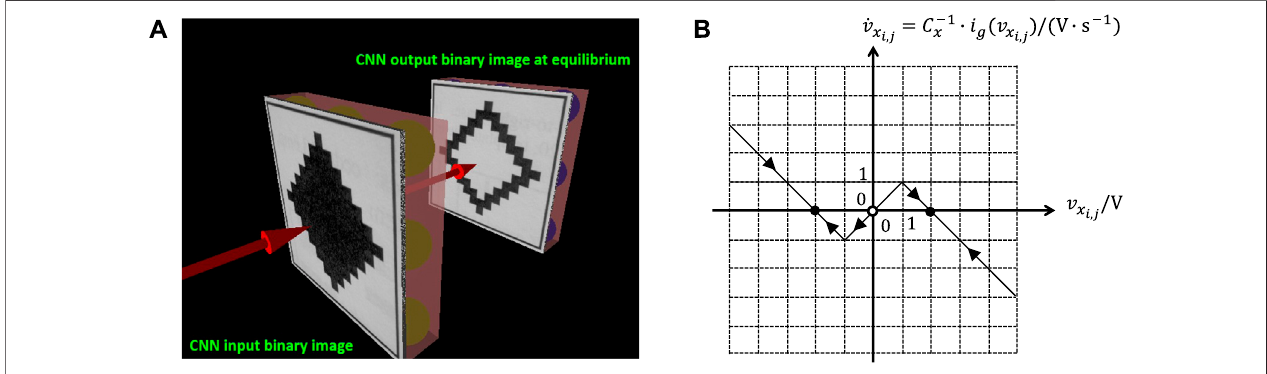
FIGURE 5 | (A) Graphical illustration of the operating principles of the CNN under design. (B) EDGE CNN SDR for zero offset current. Here C x (cid:1) 1F, R x (cid:1) 1 Ω , R y · g lin (cid:1) 1, and v sat (cid:1) 1V. The self-feedback synaptic weight a 0 , 0 (the b value for each of the feedforward synaptic weights, except for b 0 , 0 ) is set to 2 Ω − 1 ( − 1 Ω − 1 ) ahead of the application of the classical CNN design methodology from Itoh and Chua (2003). The cell equilibria lie at v x